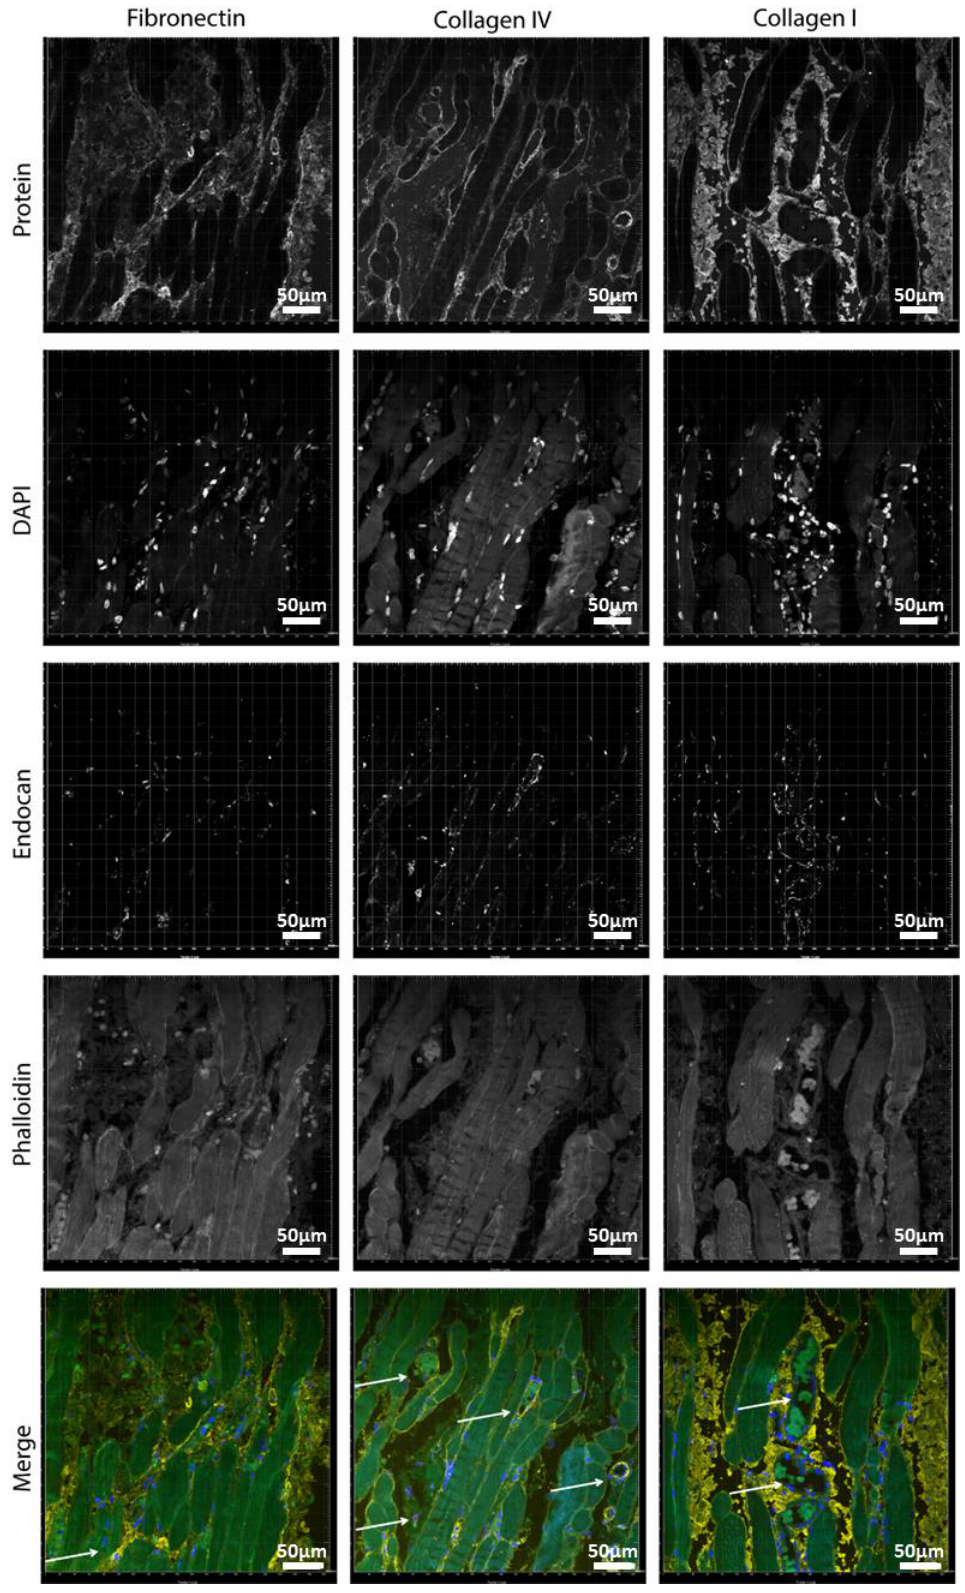
Figure 8. Localization of ECM proteins in human muscle: (left) fibronectin: (middle) collagen IV; and (right) collagen I. Blue is for DAPI, red is for endocan (EC marker), yellow is the protein of interest, and green is phalloidin (cytoskeleton). Scale bars are 50 µm.